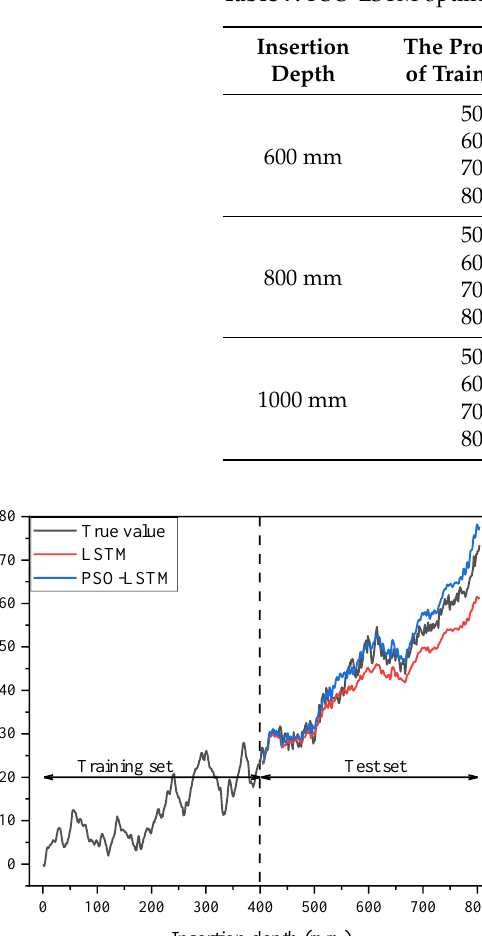
Table 7. PSO-LSTM optimization parameters for the gravel sample groups.